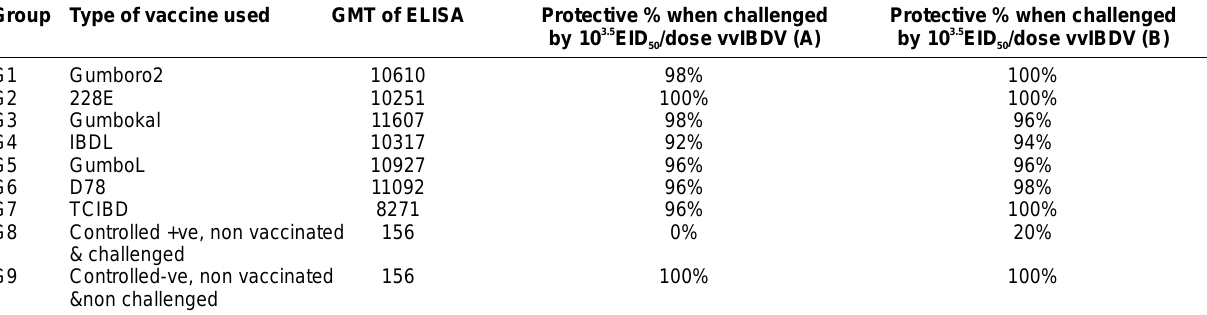
B: bursa/body weight ratio, S: spleen /body weight ratio, P: proventriculus/body weight ratio Chicks with bursa index lower than 0.7 were considered to have bursa atrophy according to [23]. *significant difference at p <0.05 Table-4. Monitoring of potency and cross protection percentage Group Type of vaccine